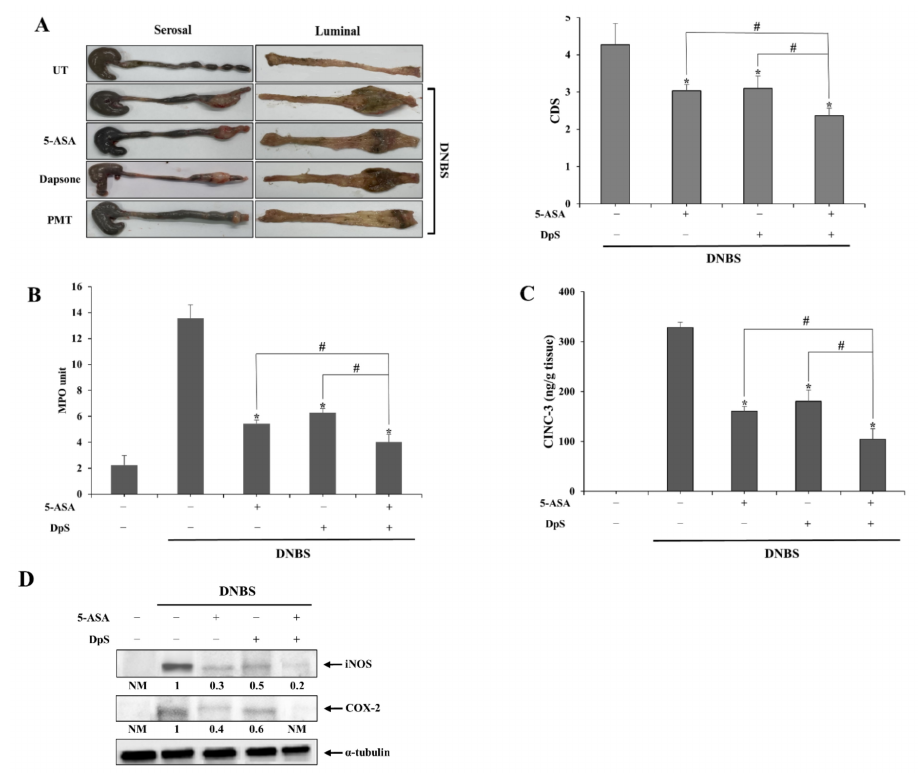
Figure 4. DpS and 5-ASA cooperate to alleviate rat colitis. Three days after colitis induction by DNBS, 5-ASA (19 mg/kg), DpS (15 mg/kg), and PMT were administered orally to rats once per day, and the rats were sacrificed after 6 days of treatment. ( A ) Left panel: Serosal and luminal sides of the distal colon of rats were photographed. Representative images are shown. Right panel: Colon damage score (CDS) was determined for each group, as described in the Section 2. * α < 0.05 vs. DNBS control, # α < 0.05. ( B ) Myeloperoxidase (MPO) activity was measured in the inflamed distal colon (4 cm). * p < 0.05 vs. control, # p < 0.05. ( C ) CINC-3 levels in the inflamed colon were measured using an ELISA kit. ( D ) iNOS and COX-2 levels were measured in the inflamed distal colon using Western blotting. * p < 0.05 vs. control, # p < 0.05. The data in ( A – C ) represent mean ± SD (n = 5). NM: not